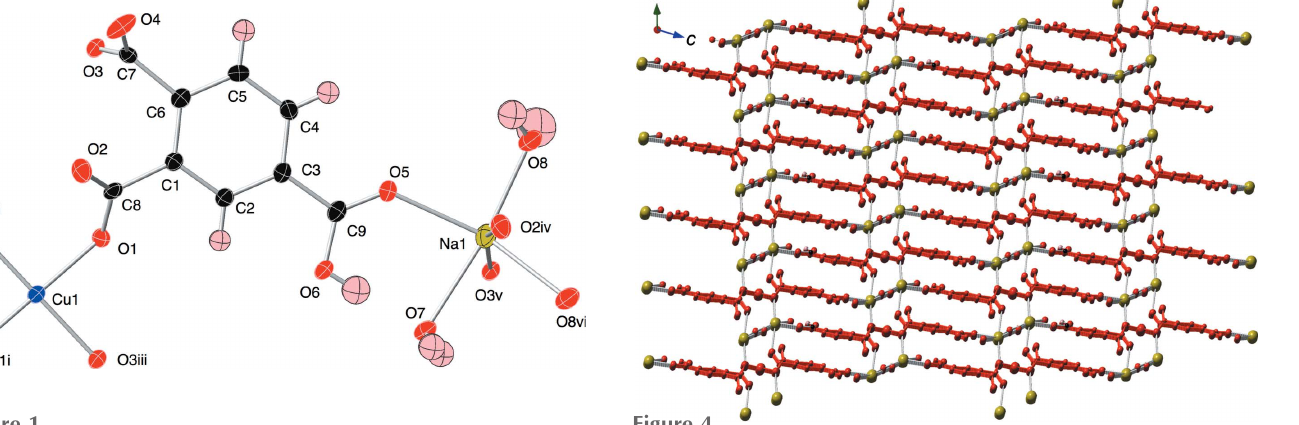
Figure 4 Connection of [Cu(btcH) 2 ] n 2 n (cid:2) coordination polymer ribbons by Na I cations to construct the [Na 2 (H 2 O) 4 Cu(btcH) 2 ] n three-dimensional coordination polymer structure of the title compound. Individual [Cu(btcH) 2 ] n 2 n (cid:2) ribbons are drawn in